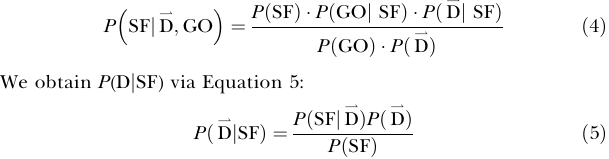
Table S1. Complete Listing of Domain Predictions for All ORFs in Yeast All 14,934 domains predicted from the 6,238 sequences are presented in detail. Table S2. Protein Structure Predictions with P MCM (cid:3) 0.8 The most confident predictions using the MCM are listed. Table S3. Protein Structure Prediction with P (SF j D,GO) (cid:3) 0.8 The most confident predictions using the GO-integration strategy are listed. Table S4. Benchmark Results Best predicted structure—the best predicted structure by RMS among the 1,000 created; Top5 is the cluster center from the five largest clusters; Best Match—the best domain match from all 30 cluster